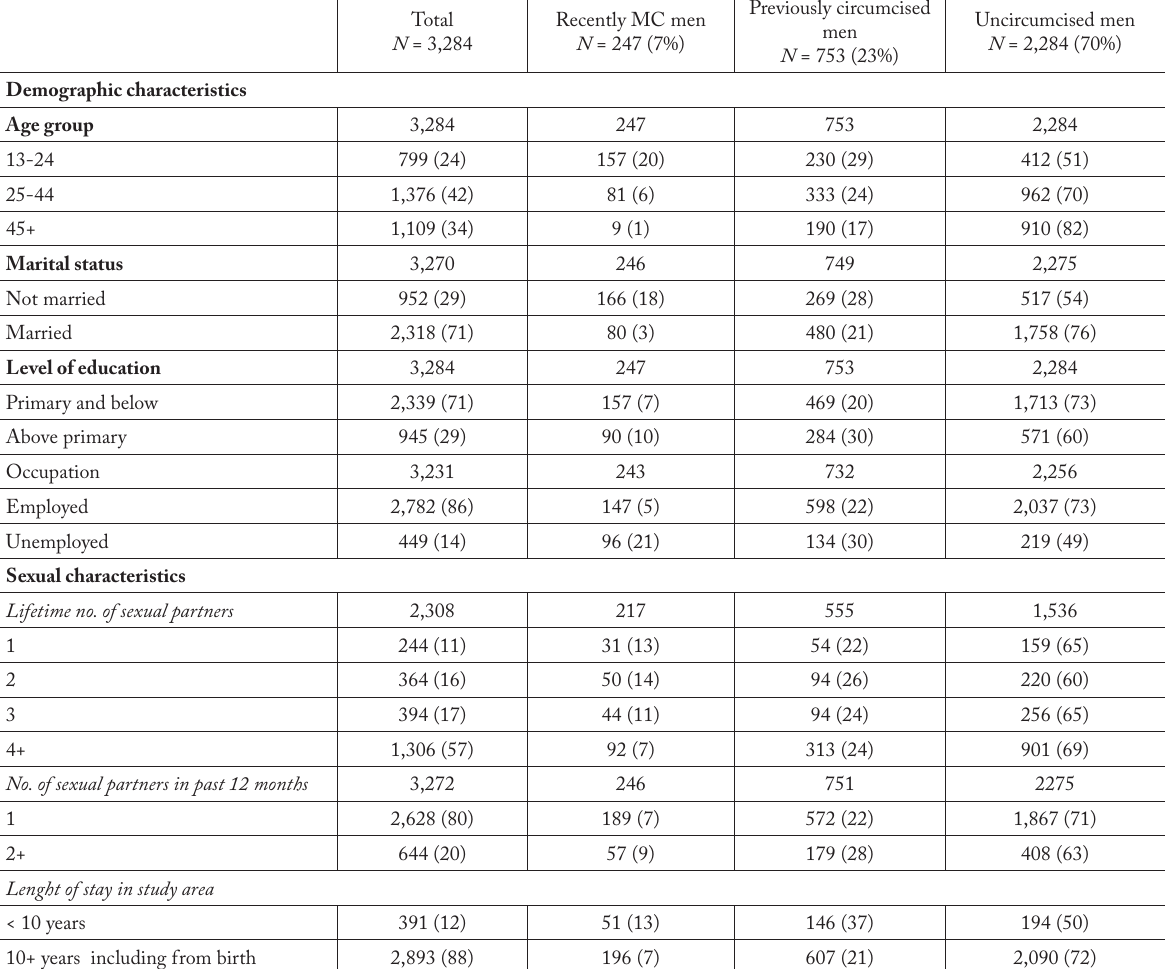
Table 1. Demographic and Sexual Characteristic Male Respondents in Gem, Siaya County, Western Kenya, 2012- 2014 ( n =